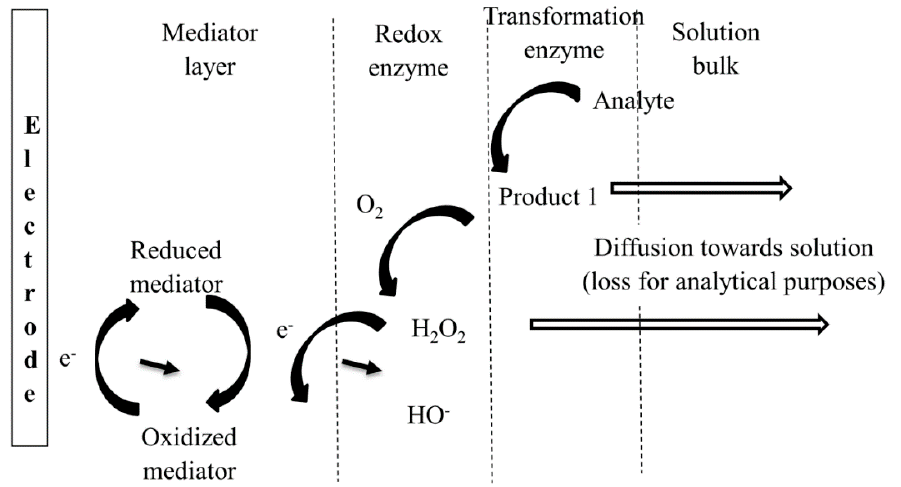
Figure 6. The schematic representation of the working principle of a bienzymatic biosensor based on analyte transformation into a product recognized by a redox enzyme followed by mediated detection of hydrogen peroxide. Note that some of the enzymatic product diffuses towards solution bulk and are lost for analytical purposes.